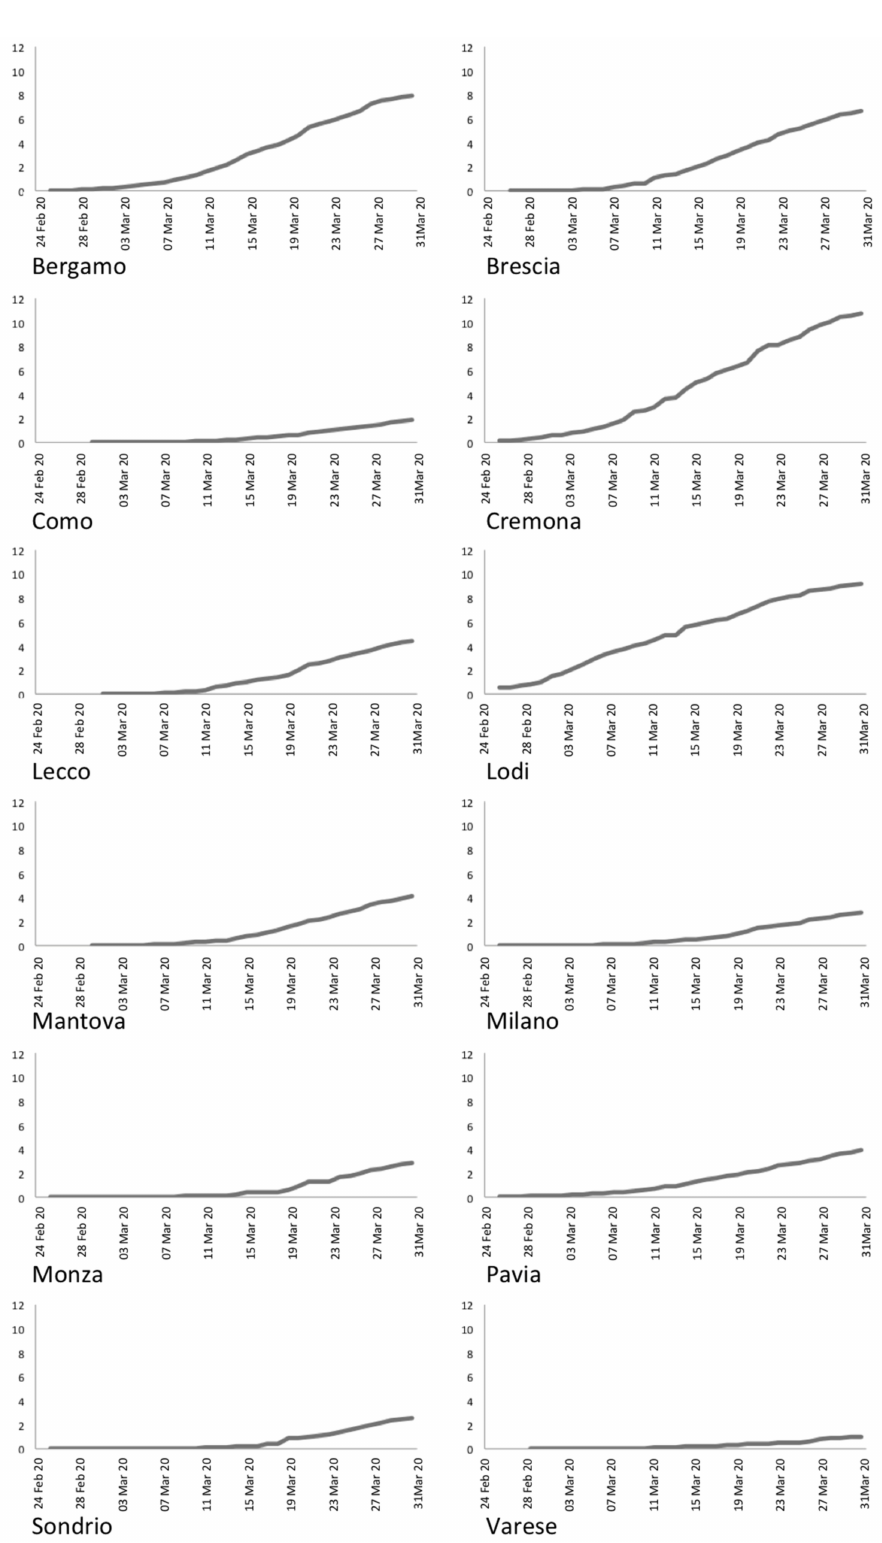
Figure 5. Daily prevalence rate for the Lombardy